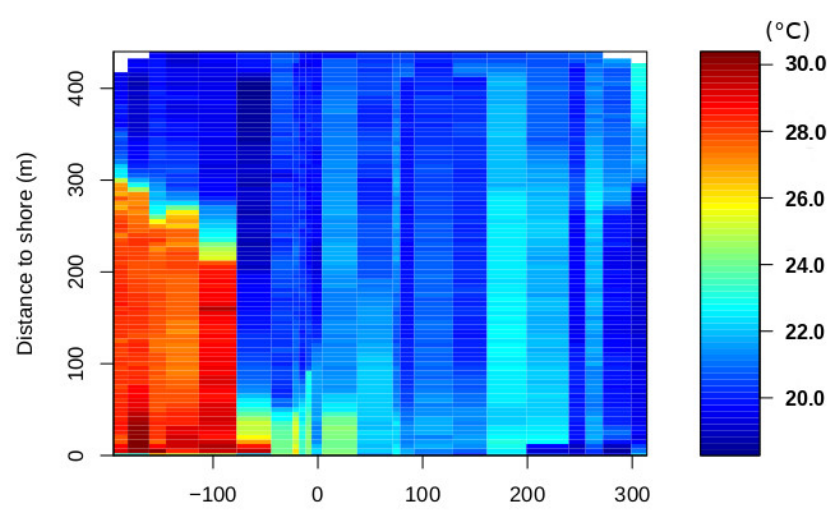
Figure 14. Temperature profiles ( ◦ C) from both days across the intertidal mudflats and the tidal channel from all datasets, arranged according to water level (for location, see Figure 13). A slightly different approach that emphasizes the temperature gradient along the profile calculates the difference from the mean profile temperature ( DeltaT p ) for every profile data point (see Figure 15). The temperature boundaries are even more pronounced.